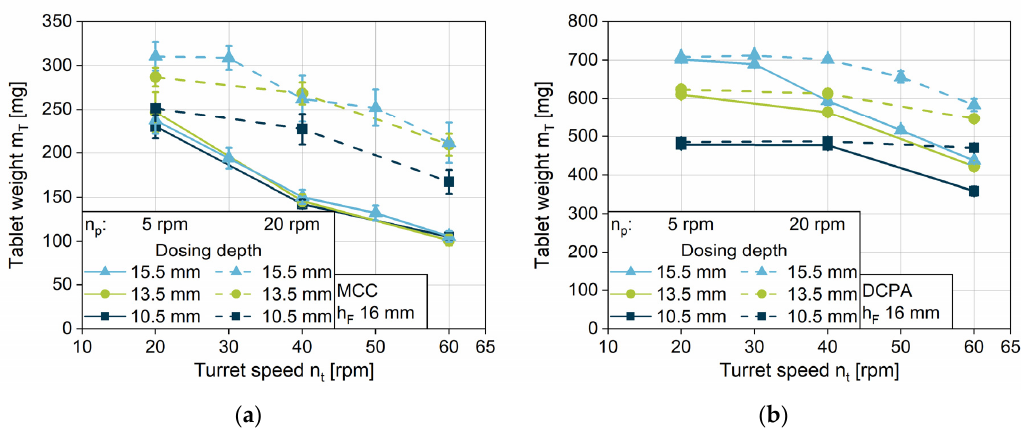
Figure 9. Effect of turret speed, paddle speed and dosing depth on the relative tablet weight variation for ( a ) MCC and ( b ) DCPA at different paddle speeds.